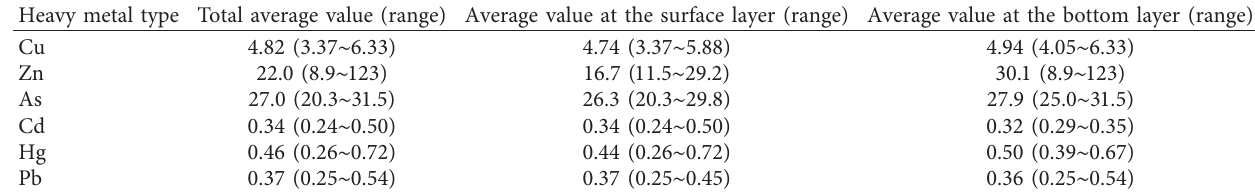
Table 3: Heavy metal contents in seawater layers of Jiuzhen Bay ( μ